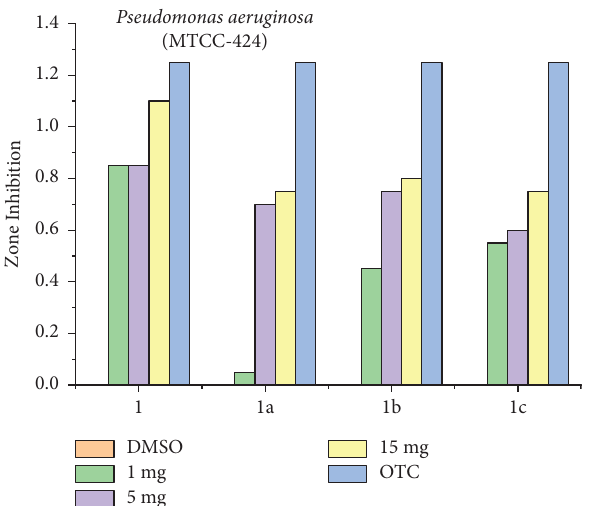
Figure 3: Radius of the zone of inhibition (mm) against P . aer- uginosa (MTCC-424) in the range of 1–15mg/mL sample ( 1 , 1a , 1b , and 1c ) with positive control of 50mg/mL oxytetracycline (OTC).